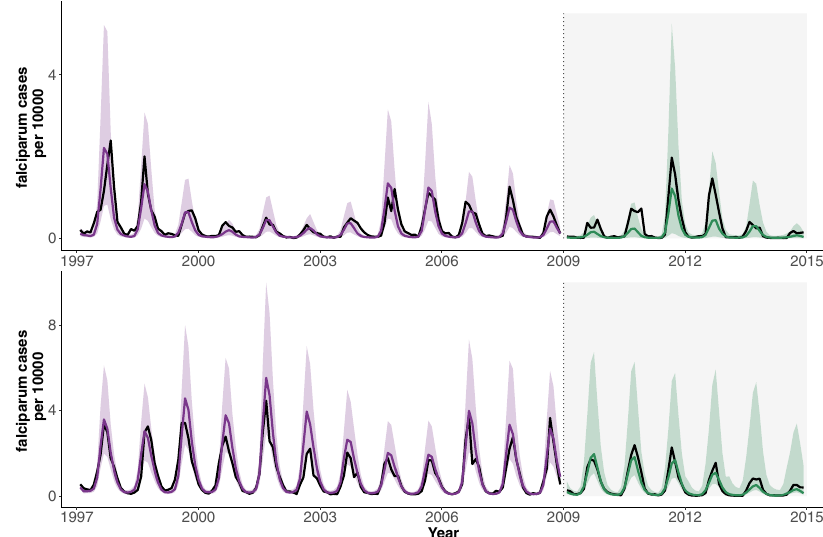
Fig. 4 Malaria prediction. The median predicted cases from 1000 simulations are shown (in purple and green) for Ahmedabad (top) and Surat (bottom) together with the observed cases (in black). Corresponding shaded purple or green intervals show the 10 – 90% quantiles of the predicted distribution of cases for each month. Vertical dotted lines and corresponding background shading indicate two different kinds of model simulations and respective predictions: (1) For the initial period (light background), the model is simulated from 1997 forward until 2009. Thus, the comparison to data here is not based on the typical next-step (next-month) prediction (for which it can often be somewhat trivial to capture the fi tted data), but on predictions that span more than a decade starting from estimated initial conditions in 1997. (2) The latter period (gray background) shows predictions for “ out-of- fi t ” years (not used to fi t the model), with simulations spanning the whole year and starting each January from the estimated state variables of the system. Predicted median cases capture the interannual variability of the data, and observations fall within con fi dence intervals (for 76% of the months). The estimation framework considers both types of noise: process noise to account for “ environmental ” stochasticity in the transmission process and observational noise as encoded in a measurement